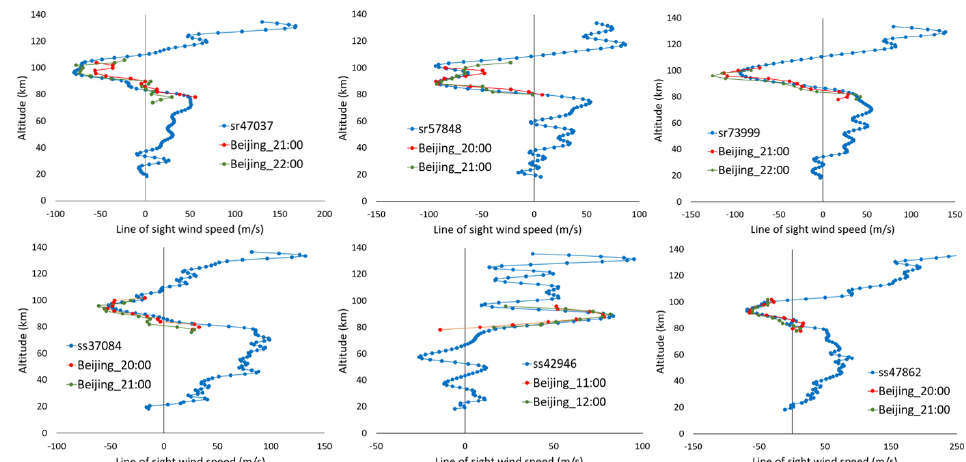
Figure 10. Selected comparisons between coincident ACE-FTS line of sight winds (in blue) and vector winds projected onto the ACE-FTS line of sight for hourly results from the Beijing meteor radar station (40.3° N, 116.2° E) prior to (in red) and after (in green) the ACE-FTS measurement. Three sunrise comparisons are shown in the top row: sr47037 (measured 7 May 2012 at 21:25), sr57848 (measured 10 May 2014 at 20:55), and sr73999 (measured 8 May 2017 at 00:30). The bottom row shows comparisons with ACE-FTS sunsets: ss37084 (measured 2 July 2010 at 20:50), ss42946 (measured 4 August 2011 at 11:25), and ss47862 (measured 2 July 2012 at